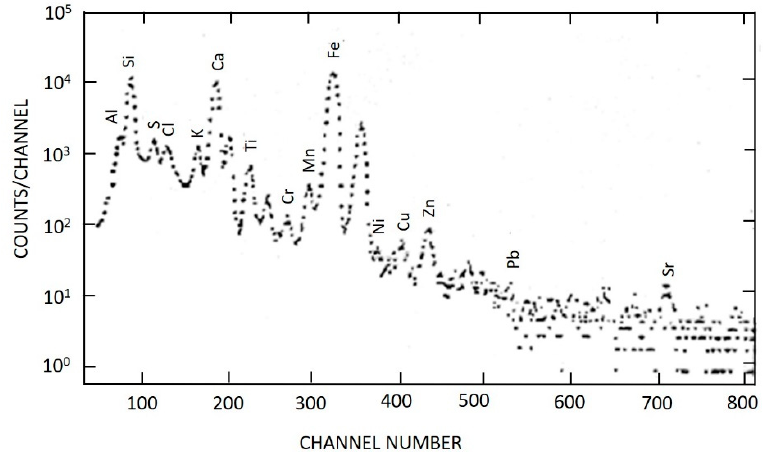
Figure 7. PIXE spectrum of airborne dust in Sapporo, Japan in April of 1982.